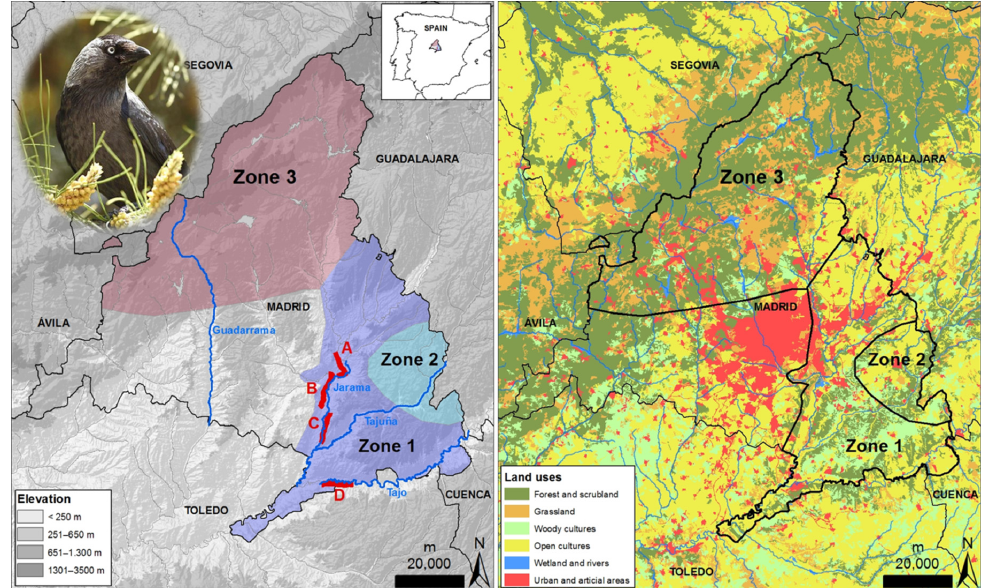
Figure 1. Left panel: map of the study area showing the location of the cliff sectors (A-D letters and associated areas, in red), riverside forests across rivers (blue lines) surveyed for jackdaws during the breeding season in each zone (1–3) in Madrid province, Central Spain. Right panel: habitats characterizing each zone according to Corine land cover (https://land.copernicus.eu/pan-european/corine-land-cover/clc2018?tab=metadata; accessed on 24 May 2021).